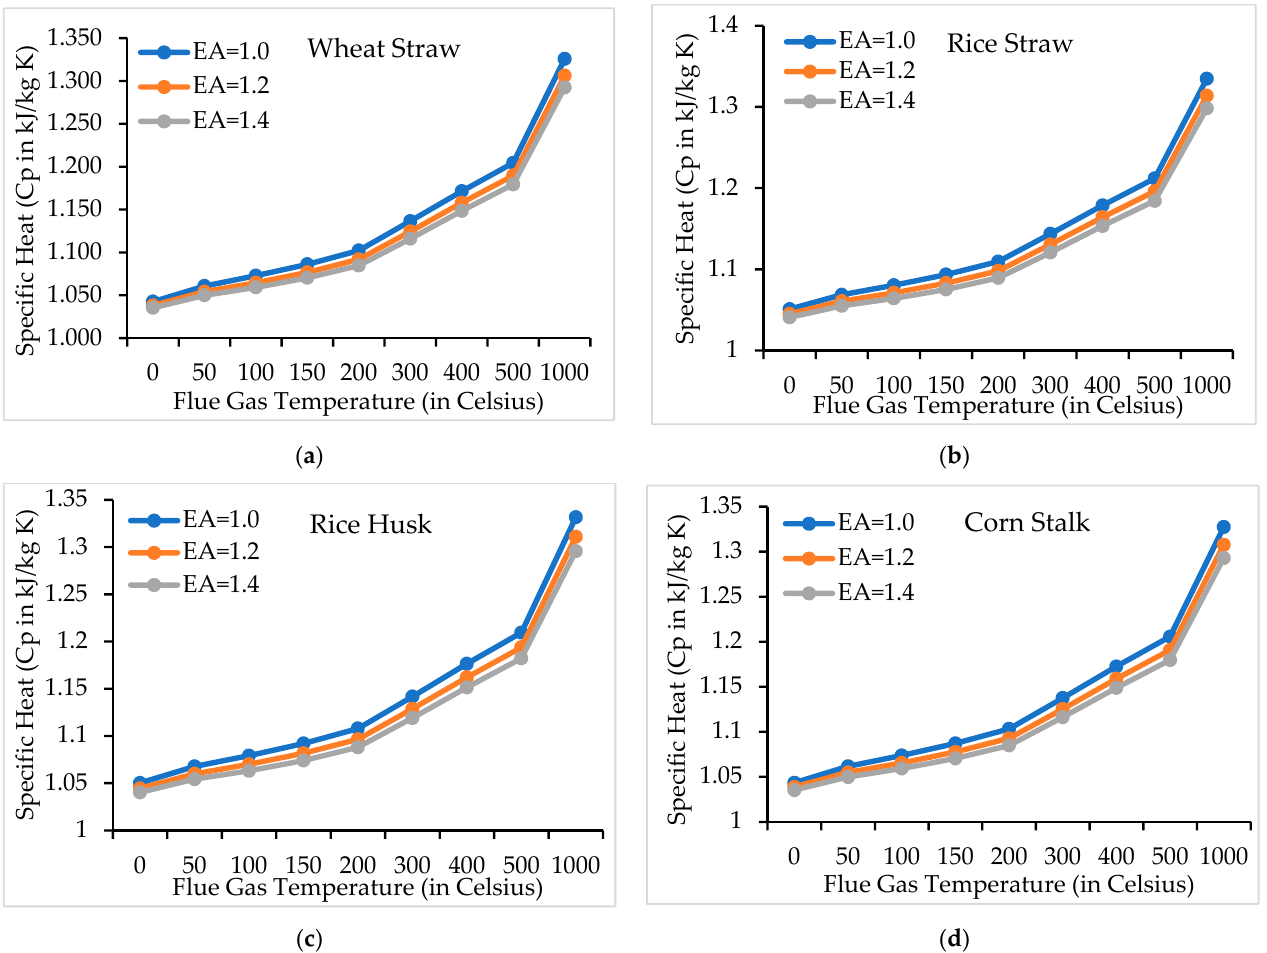
Figure 5. Specific heat of flue gas during the agricultural crop residues combustion